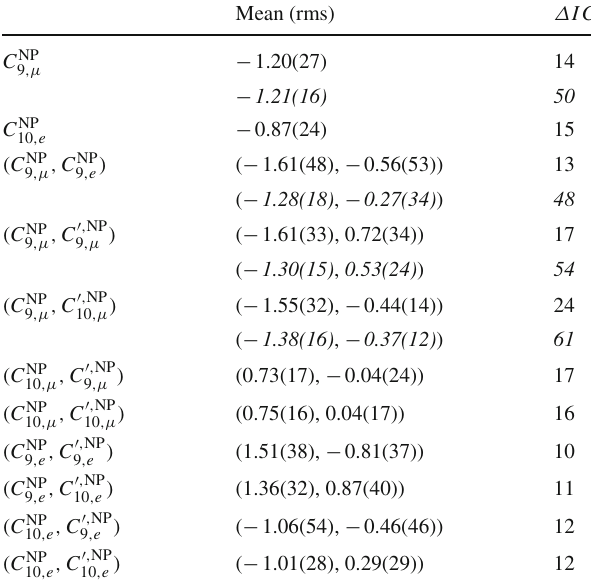
Table 1 Values of the WET WCs fit from data in all the considered scenarios along with relative Δ IC . The italic values highlight the PMD results when this approach can be used to address the experimental data in a particular scenario. The PDD results are presented for all cases. For the definition of the two approaches, see Sect. 2.1